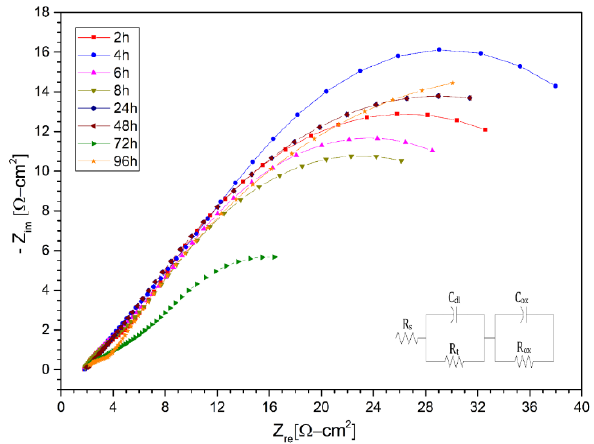
Figure 10. Nysquist diagram of stainless steel 304 layer in (LiNaK)NO 3 (ternary salt with lithium content). at 2 h, 4 h, 6 h, 8 h, 24 h, 48 h, 72 h and 96 h at 550 °C. Table 6. Fitting results of the impedance spectra of stainless steel AISI 304 during corrosion in the presence of LiNaKNO 3 (ternary salt with lithium content) at 550 °C.